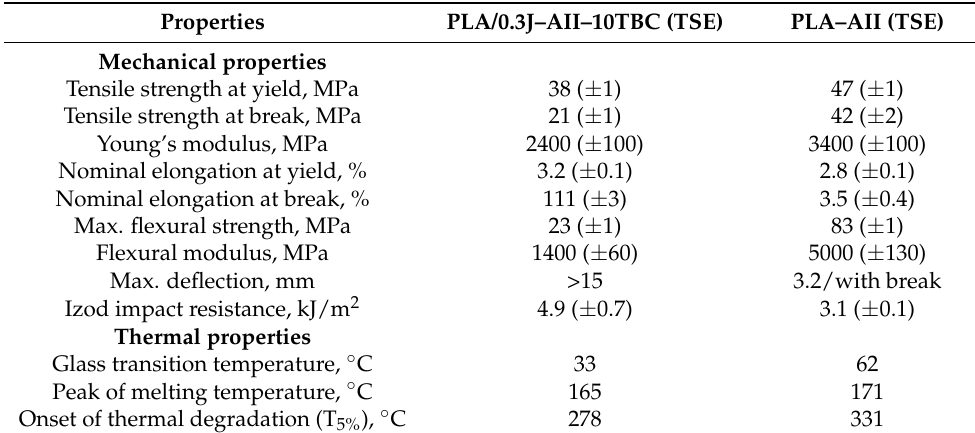
Table 6. Comparative properties of plasticized composites produced by REX and of unplasticized composites (PLA–AII).